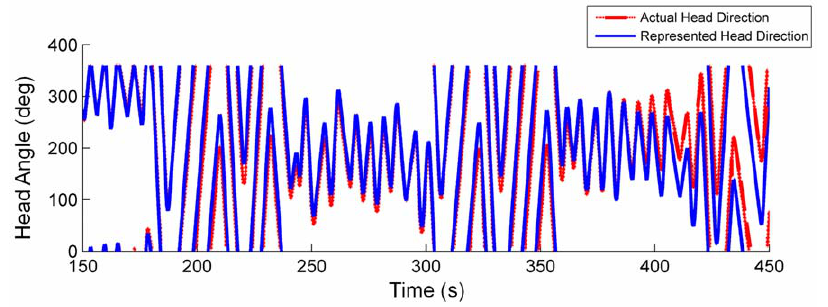
Figure 9. Typical head tracking in darkness maintains reasonable accuracy for several minutes. Actual and represented head directions are initially aligned at 150 s; over the next 5 minutes (300 s), angular disparity slowly increases. The error arises due to slight residual imbalances (directional biases) in the HD connections, causing the HD bump to move faster in one direction than the other in certain bump locations, as well as a small speed-dependent (nonlinear) response of the HD bump to varying input current from the asymmetric AHV cells.